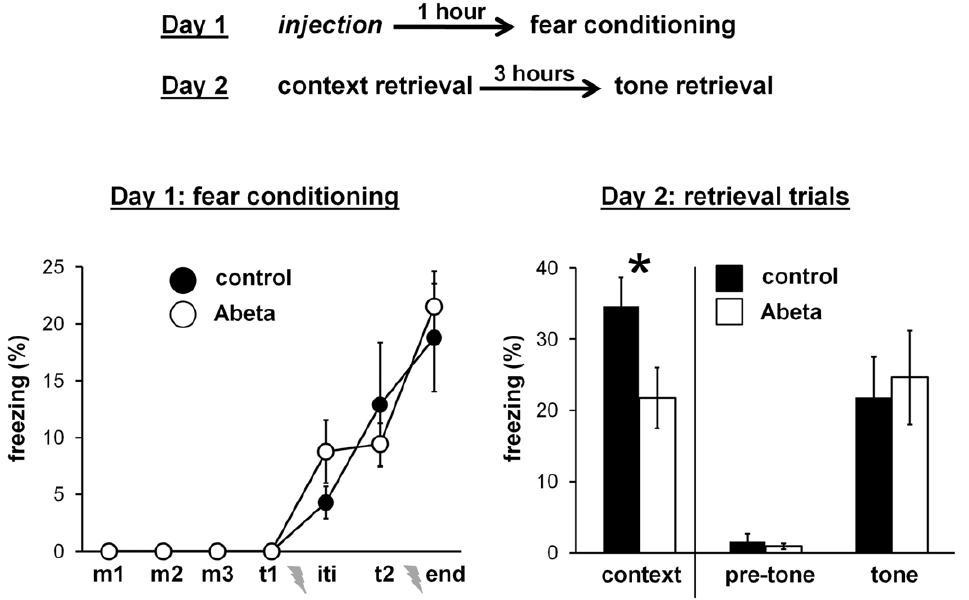
Figure 3. Experiment 2: single Abeta injection 1 hour before fear conditioning. Top) Diagram showing the design of experiment 2. Separate groups of mice were injected one time with either control or Abeta solution 1 hour before fear conditioning. Bottom) Graphs showing average freezing scores during fear conditioning on day 1 and the two retrieval trials on day 2. Mice injected with the Abeta solution (n=8) had significantly lower freezing scores during the context fear retrieval trial as compared with mice injected with the control solution (n=10). Error bars are standard errors of means. * P , 0.05.